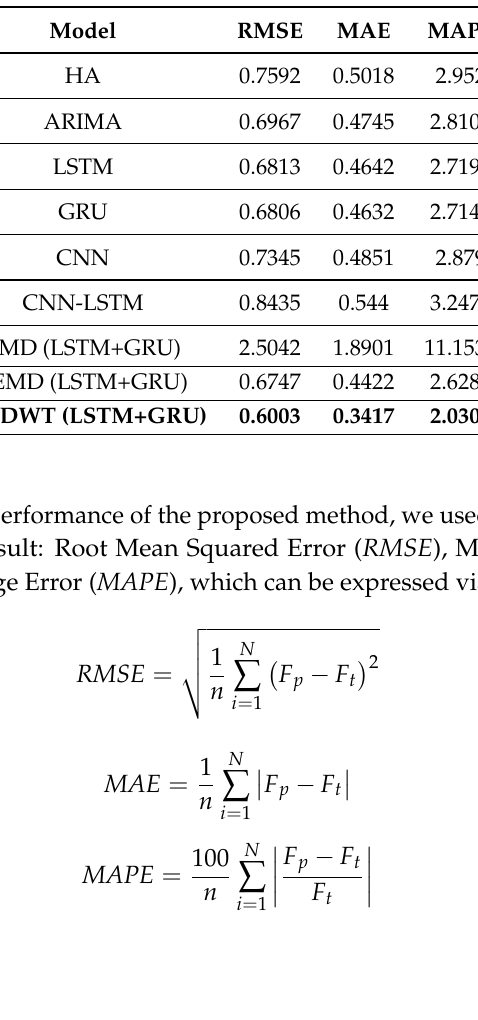
Table 4. Prediction performance of different